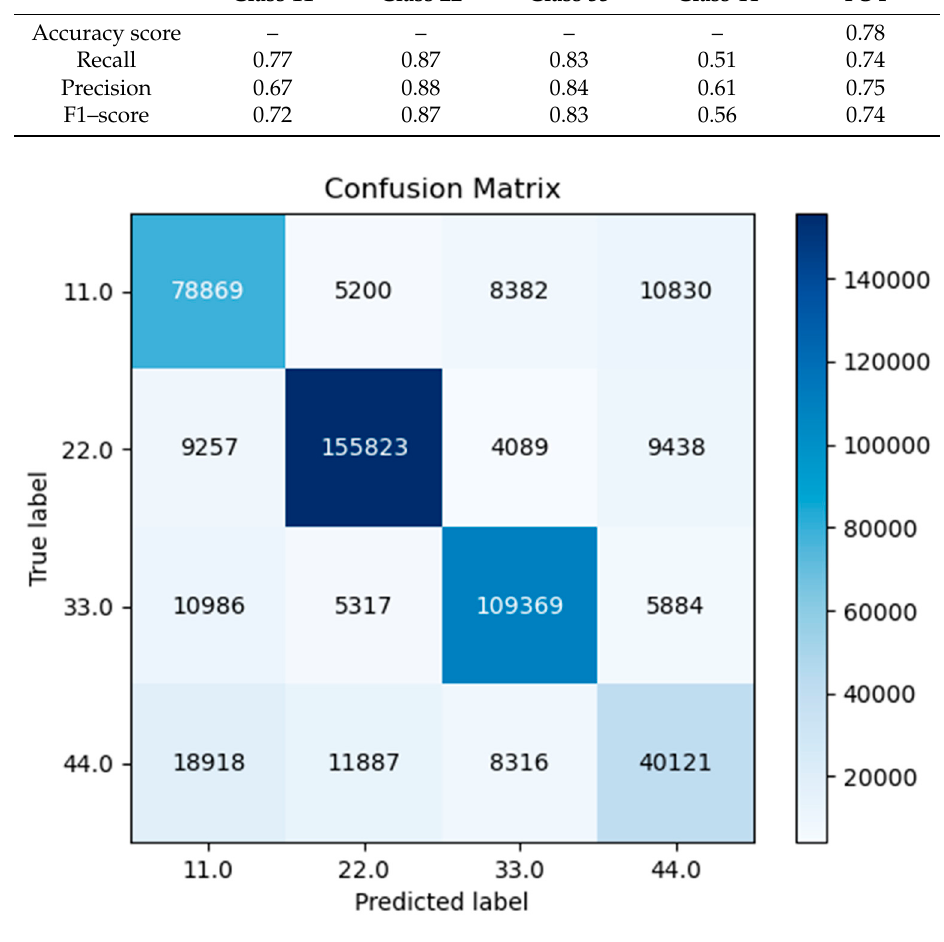
Figure 14. Confusion Matrix sketch in ML classification processing.